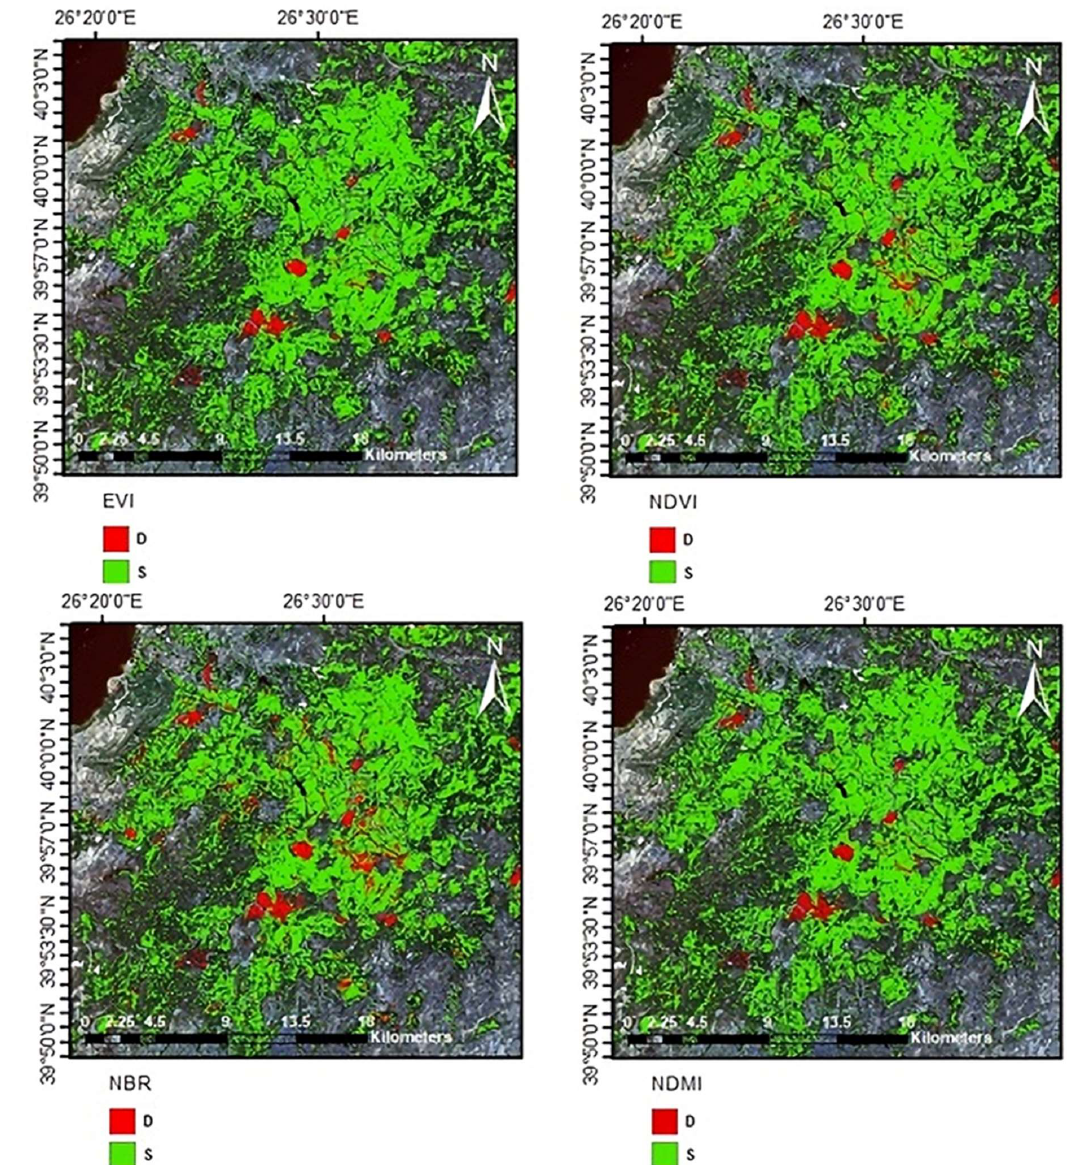
Figure 8. Demonstrating deforestation (D) and stable (S) spots in site B for all